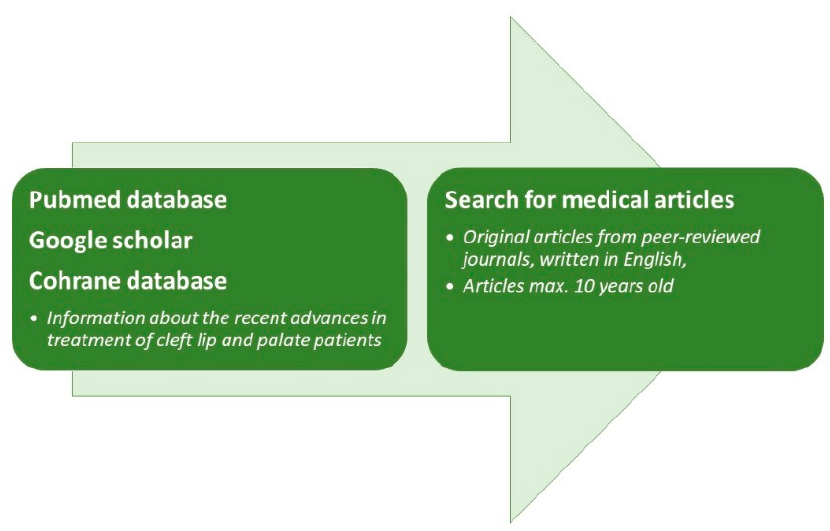
Figure 1. The inclusion criteria of papers incorporated to the study.